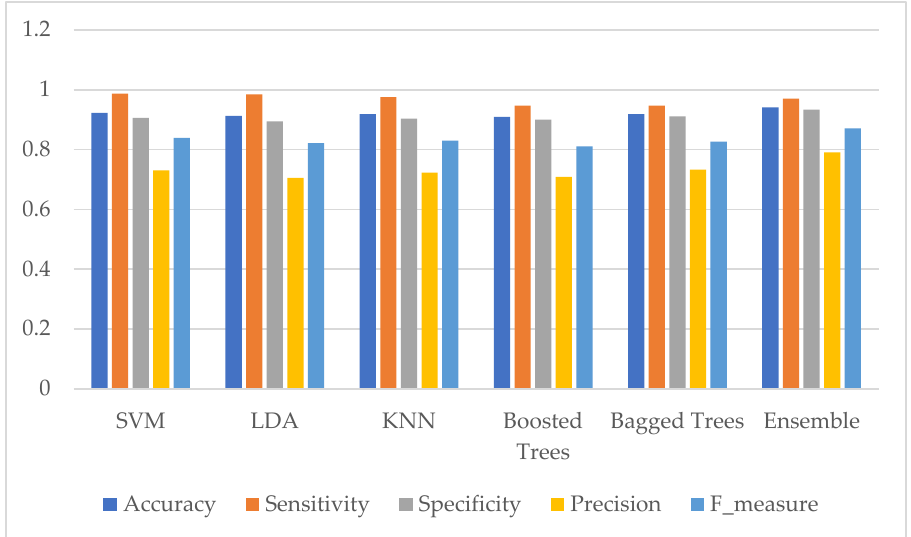
Figure 16. Evaluation of classifier’s performance using selected features for the SIPAKMed dataset in the two-class problem.